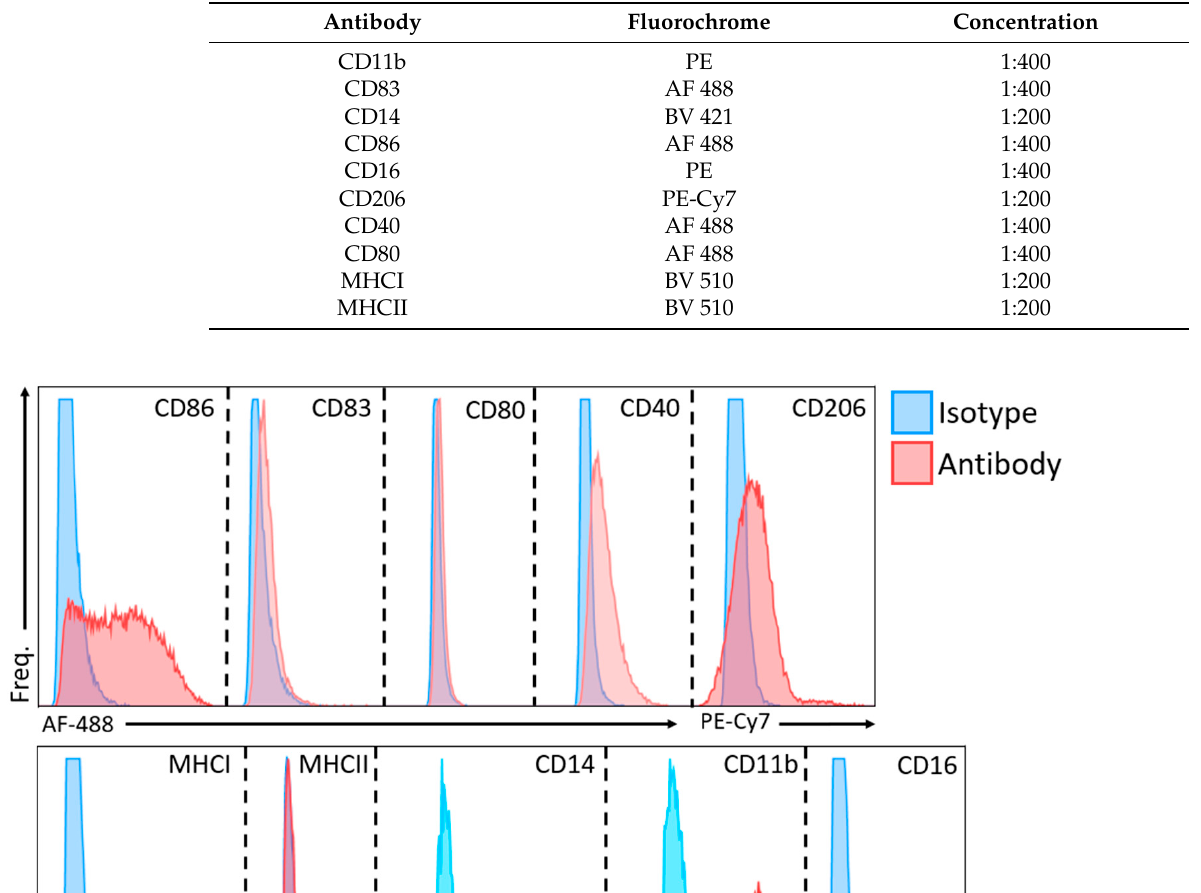
Table 1. Antibody targets, conjugations and working concentrations.